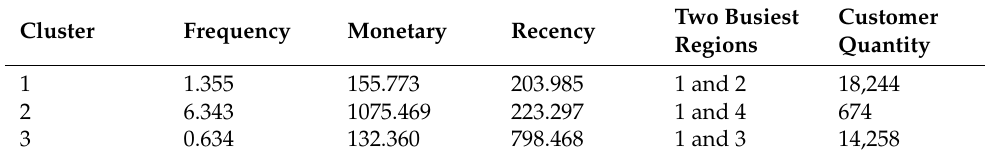
Figure 7. Variation of WSS value with the number of customer clusters. Table 2. Characteristics of the customer clusters.